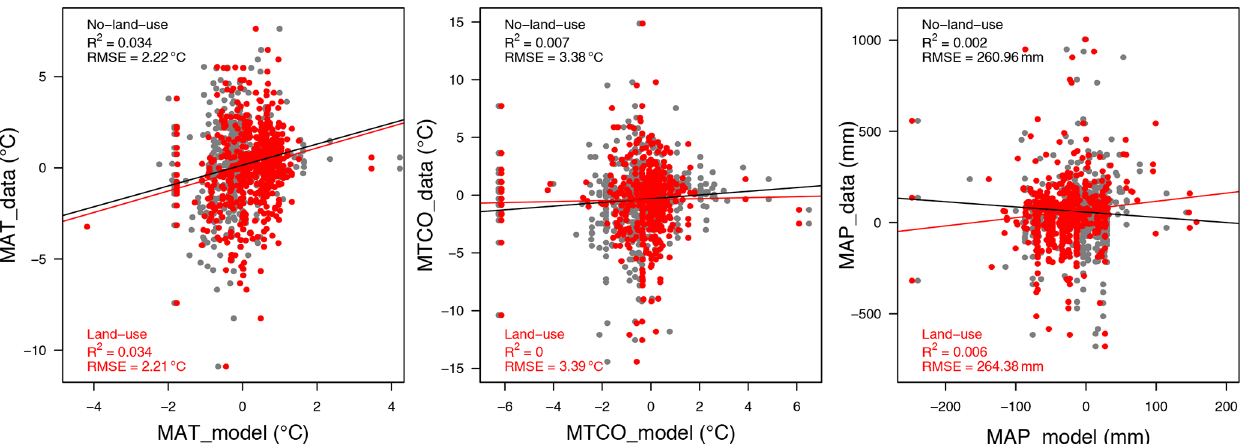
Figure 8. Quantitative comparison of the change in climate between the mid-Holocene (6ka) and the pre-industrial period as shown by pollen-based reconstructions gridded to 2 × 2 ◦ resolution to be compatible with the model resolution (from Bartlein et al., 2011) and in simulations with and without the incorporation of land use change (from Smith et al., 2016). This figure illustrates the approach that will be taken to evaluate the impact of new LULC scenarios on climate. The imposed land use changes at 6000 years ago (6kaBP) were derived from the KK10 scenario (Kaplan et al., 2011). The plots show comparisons of mean annual temperature (MAT), mean temperature of the coldest month (MTCO), and mean annual precipitation (MAP) for the northern extratropics (north of 30 ◦ N); each dot represents a model grid cell in which comparisons with the pollen-based reconstructions are possible. Although the incorporation of land use produces somewhat warmer and wetter climates in these simulations, overall the incorporation of land use produces no improvement of the simulated climates at sites with pollen-based